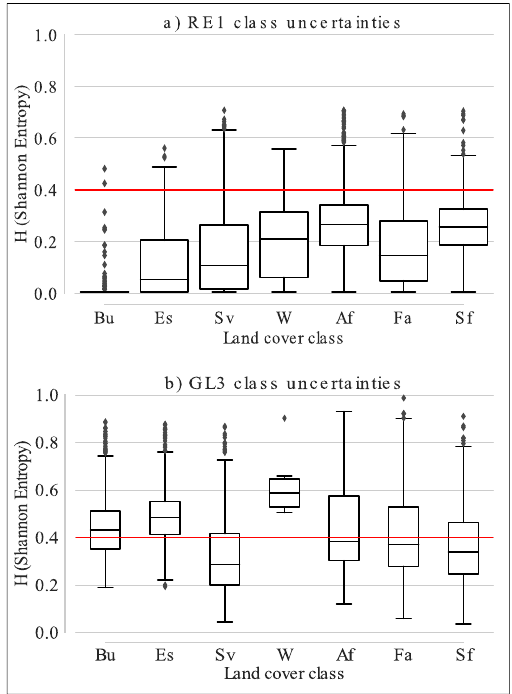
Figure 6: Comparison of individual class Shannon entropy (H) or uncertainty, for, a) single date multi-spectral optical image (RF model RE1) b) multi-season SAR image texture-based classification (RF model